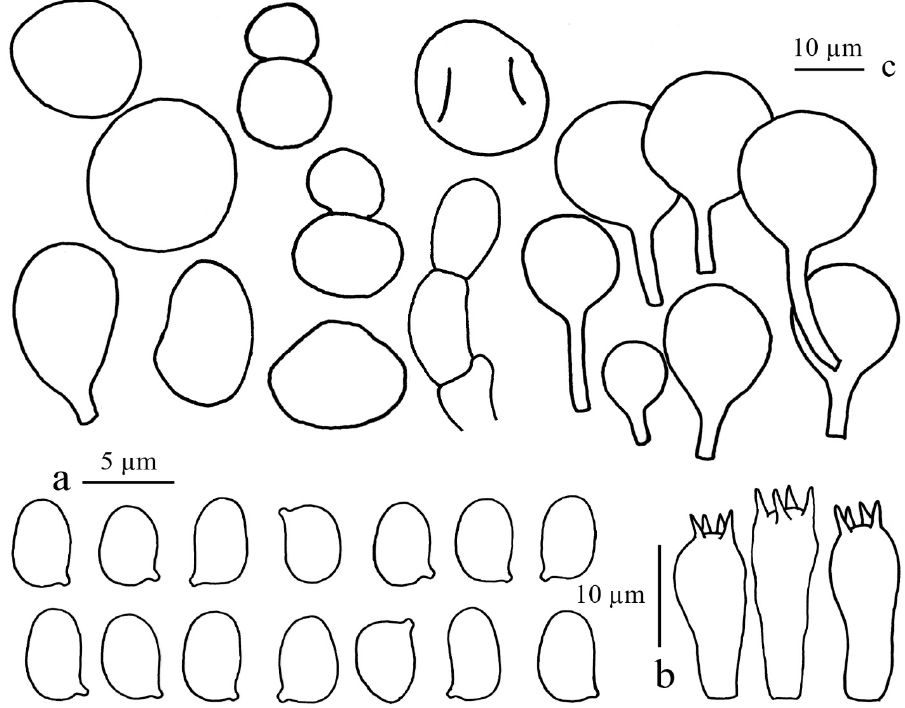
Figure 4 . Macrocharacters of Cystolepiota thailandica . ( a , b ) = MFLU22-0017 (holotype), ( c , d ) = MFLU22-0018 (paratype).